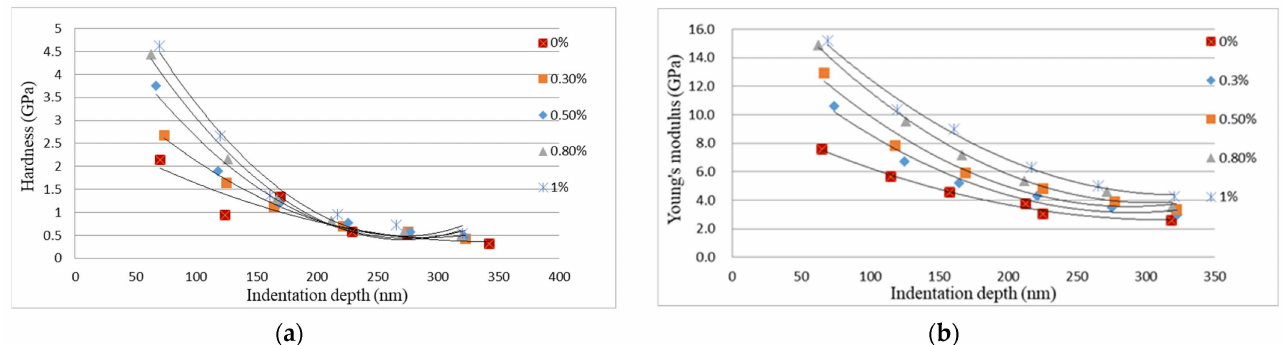
Figure 10. Hardness and Young’s modulus of the nanocomposite films reinforced with different loadings of GNP. ( a ) Hardness vs. indentation depth ( b ) Young’s modulus vs. indentation